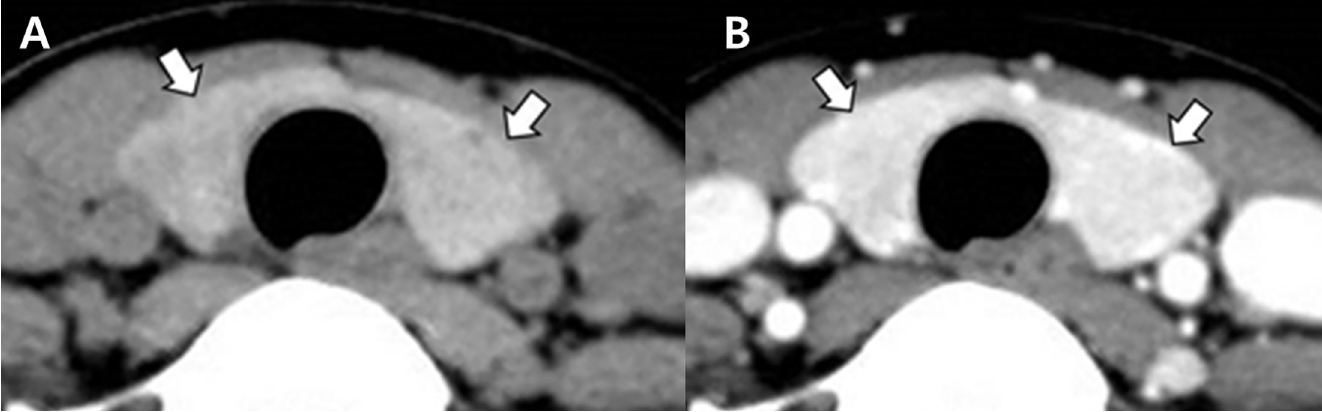
Fig 1. Computed tomography (CT) images in a 37-year-old woman with normal thyroid parenchyma on the histopathological examination that was designated as “no DTD” CT category (papillary thyroid carcinoma in the left lobe). The thyroid gland (arrows) shows iso- and homogeneous attenuation in the non-enhanced CT image (A), normal and homogeneous enhancement in the contrast-enhanced CT image (B), and an anteroposterior diameter of 1–2 cm and a smooth margin in both the non-enhanced and contrast-enhanced CT images.